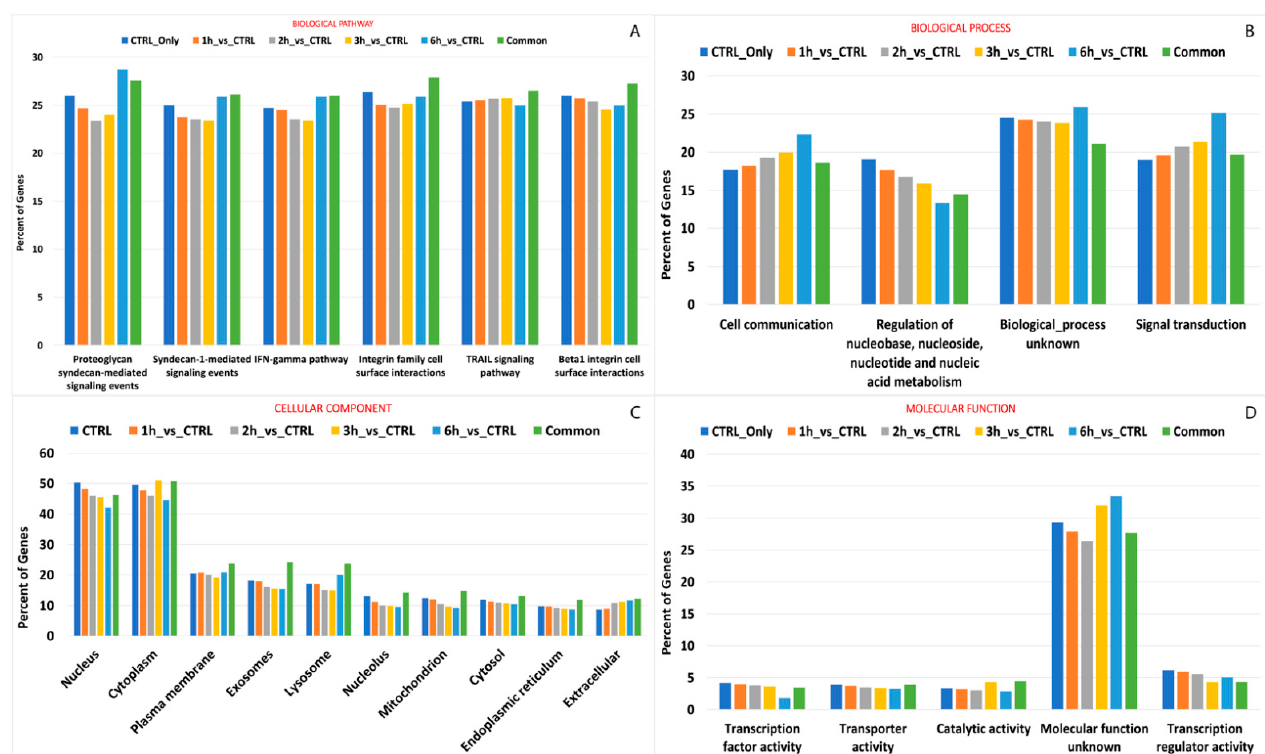
Figure 8. GO and KEGG enrichment of genes with differential editing levels . The vertical bar plots show the percentage of genes involved in top ranked pathway enrichment analyses, providing hierarchical relationships for the gene products based on biological pathway ( A ) and process ( B ), cellular component ( C ) and molecular function ( D ). Details on ranking criteria can be found in the